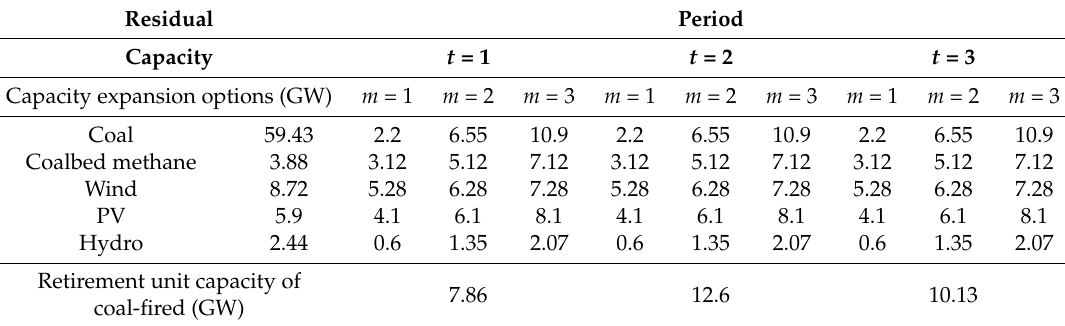
Table 3. Parameters for the capacity of different power generation